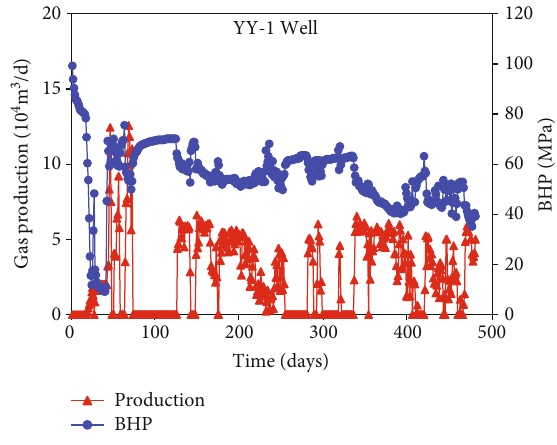
Figure 3: Production data for gas well YY-1.